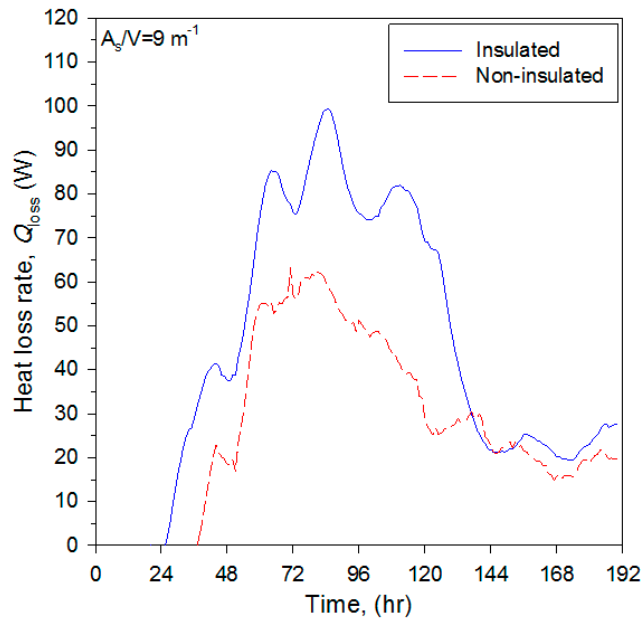
Figure 7. Total heat loss rate ( Q loss ) from inside to outside insulated and non-insulated bioreactors during the composting process.